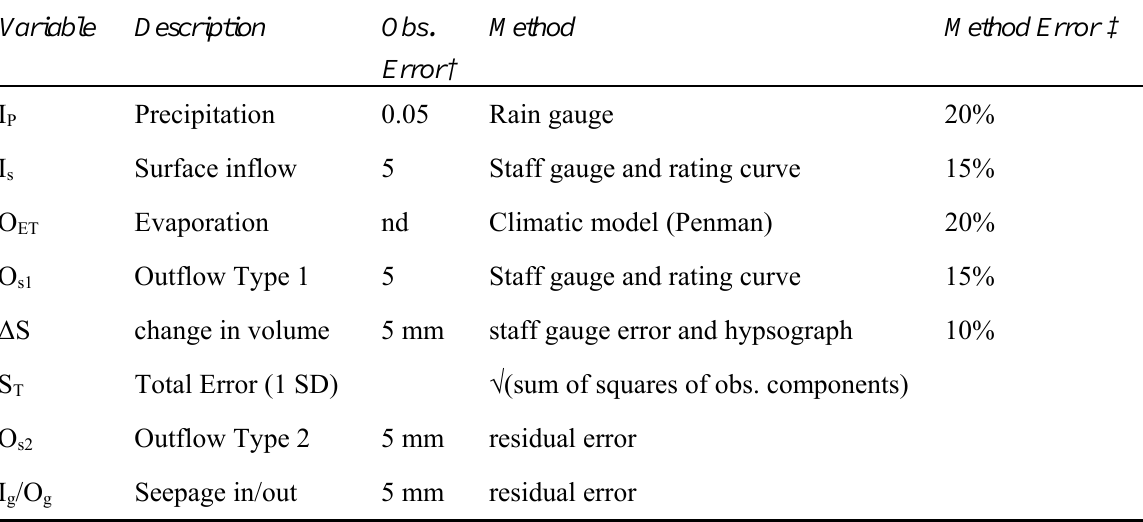
Table 2. Methods of estimation of model variables and uncertainty in